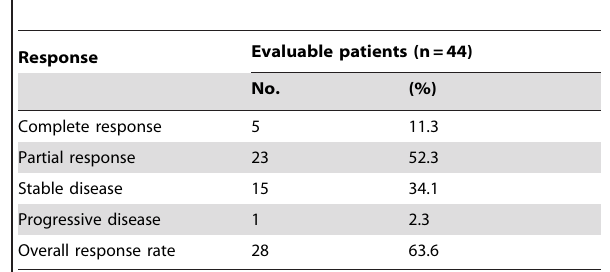
Table 2. Response to therapy.